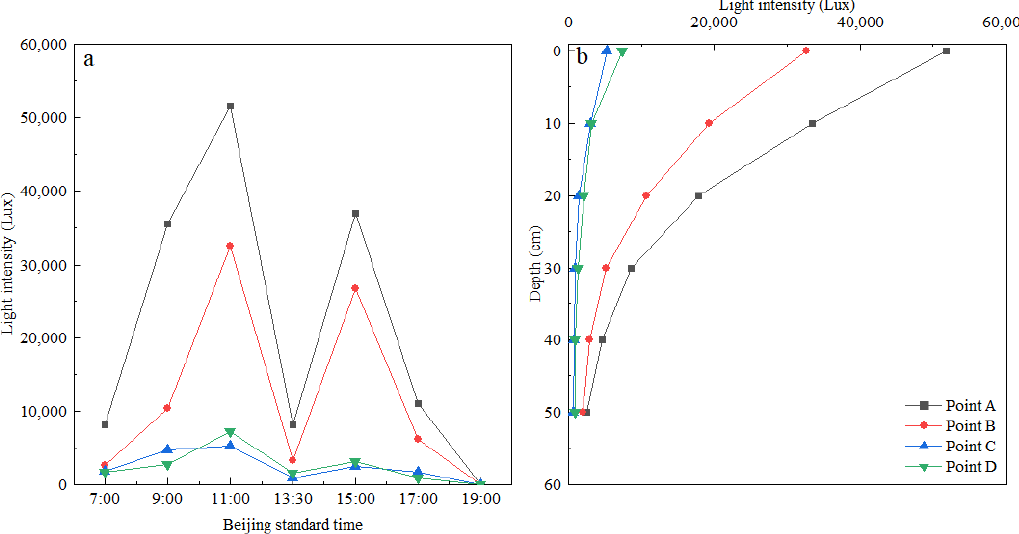
Figure 3. Characteristic curves of light intensity change in different positions and water layers. ( a ) Daily change of light intensity at different sampling points, ( b ) Variation of light intensity at different sampling points with water depth.